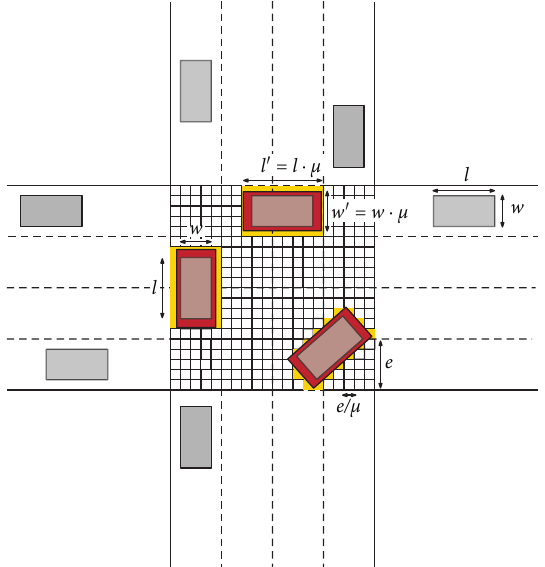
Figure 10: Illustration of the refined grid array at the IR. Inside the IR, the dimensions of the vehicles are artificially expanded as a means to introduce a space-buffer for their collision-free motion. The colored elements represent the occupied cells of the